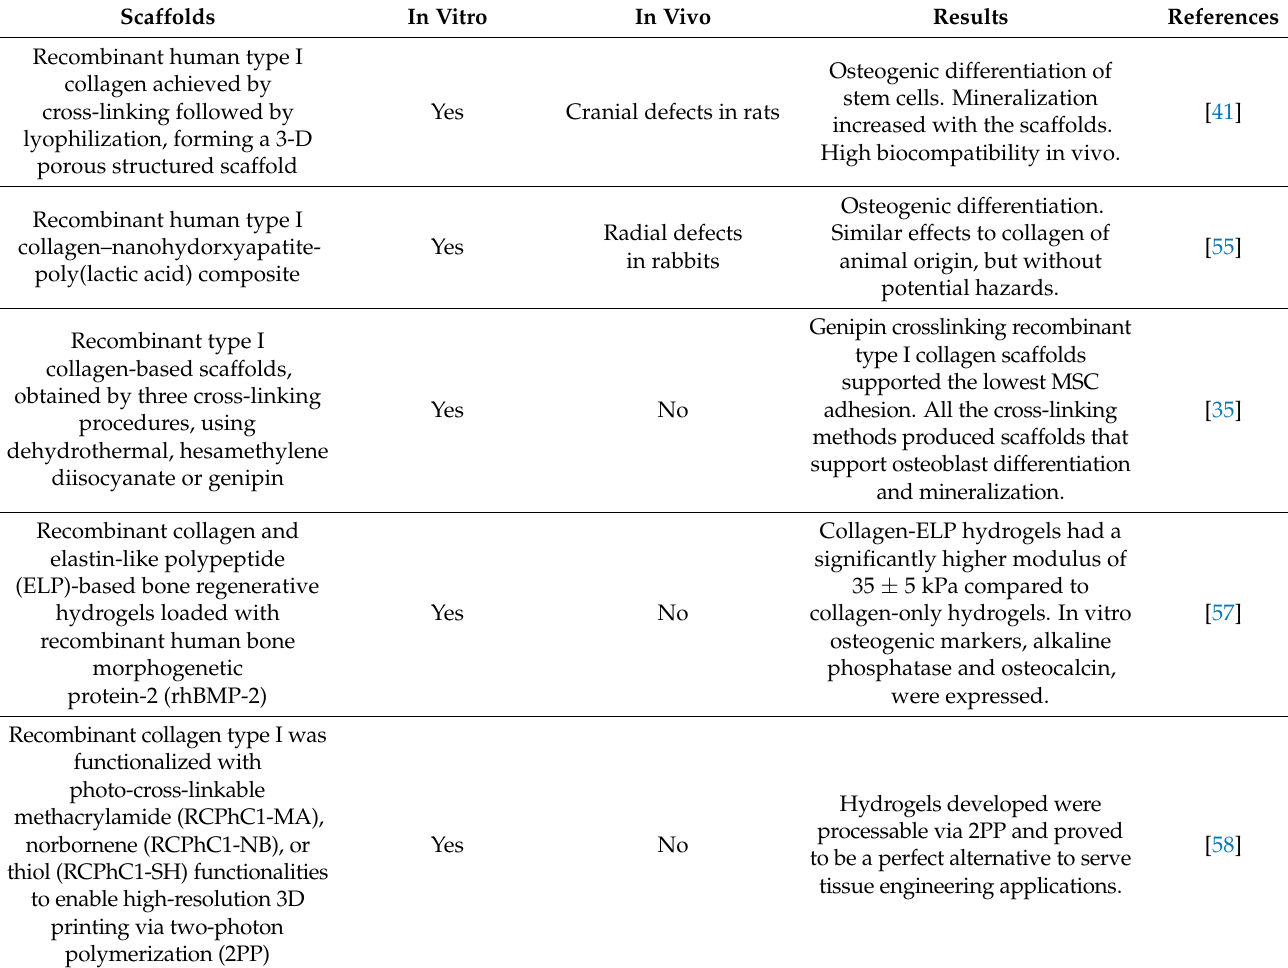
Table 2. Outstanding work applying recombinant human collagen in tissue engineering